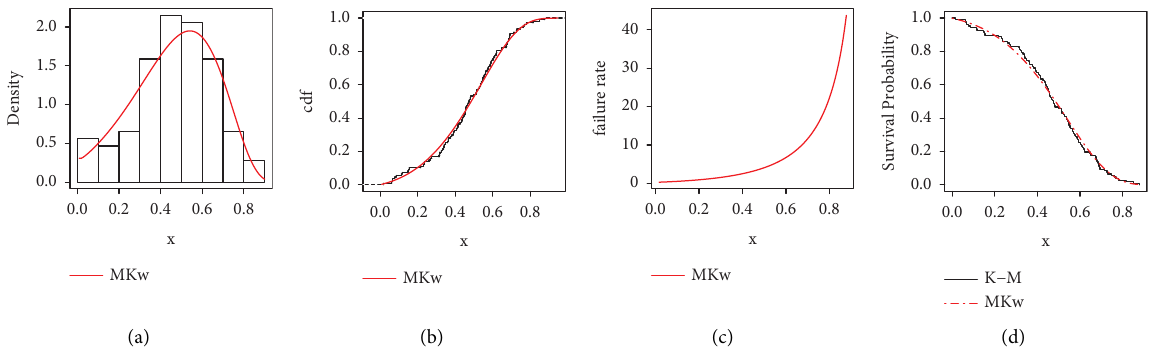
Figure 9: Plots of estimated pdf, estimated cdf, estimated hrf, and failure rate for data set 3.